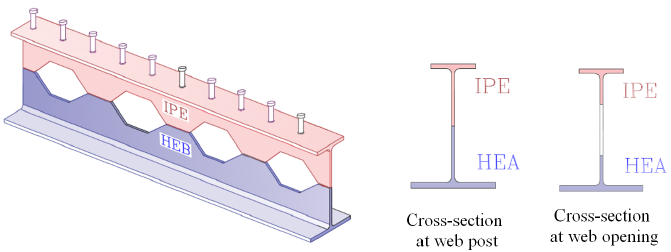
Figure 3: Asymmetrical castellated steel